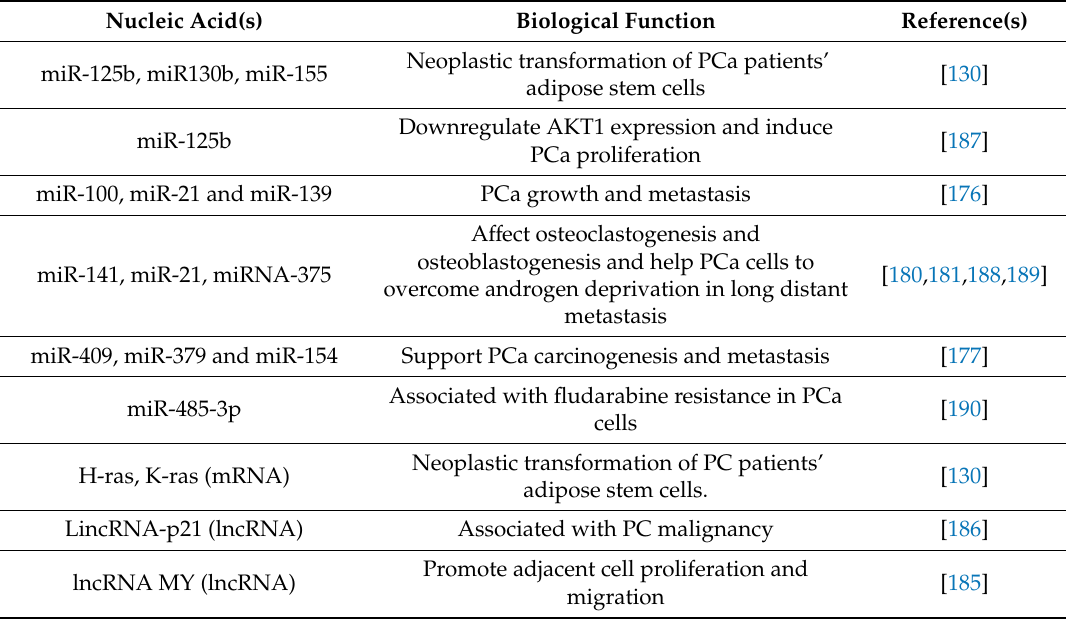
Table 2. PCa-associated exosomes transfer nucleic acids in their cargo, which have significant functions in